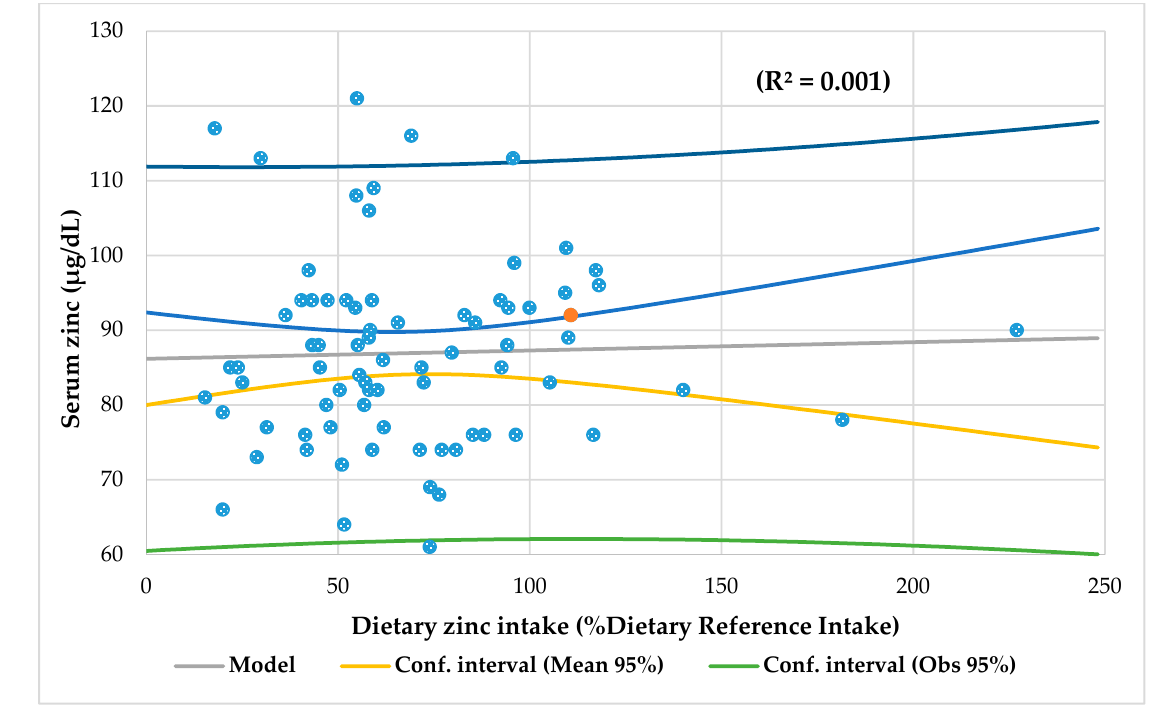
Figure 3. Correlation between serum zinc and dietary zinc intake in the entire series ( N = 78).